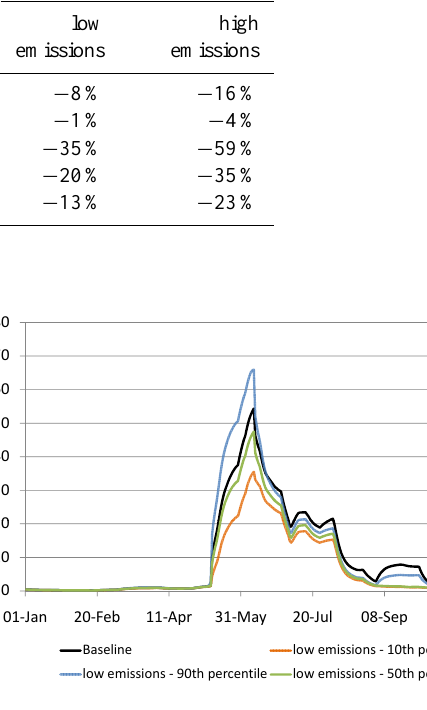
Fig. 6. One year time-slice (1999) of the hydrograph for baseline and low emissions